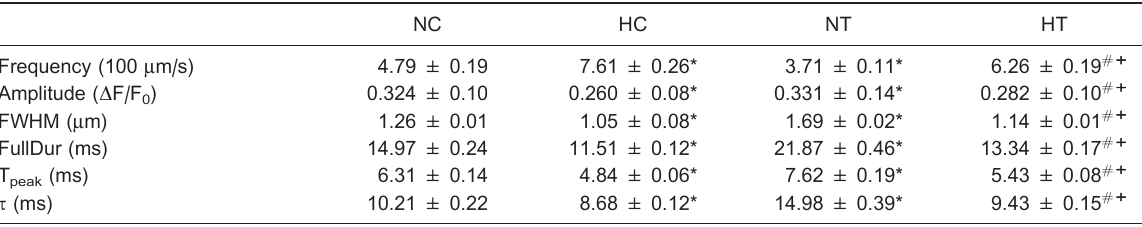
Table 1. Characteristics of spontaneous Ca 2++ sparks in left ventricular isolated